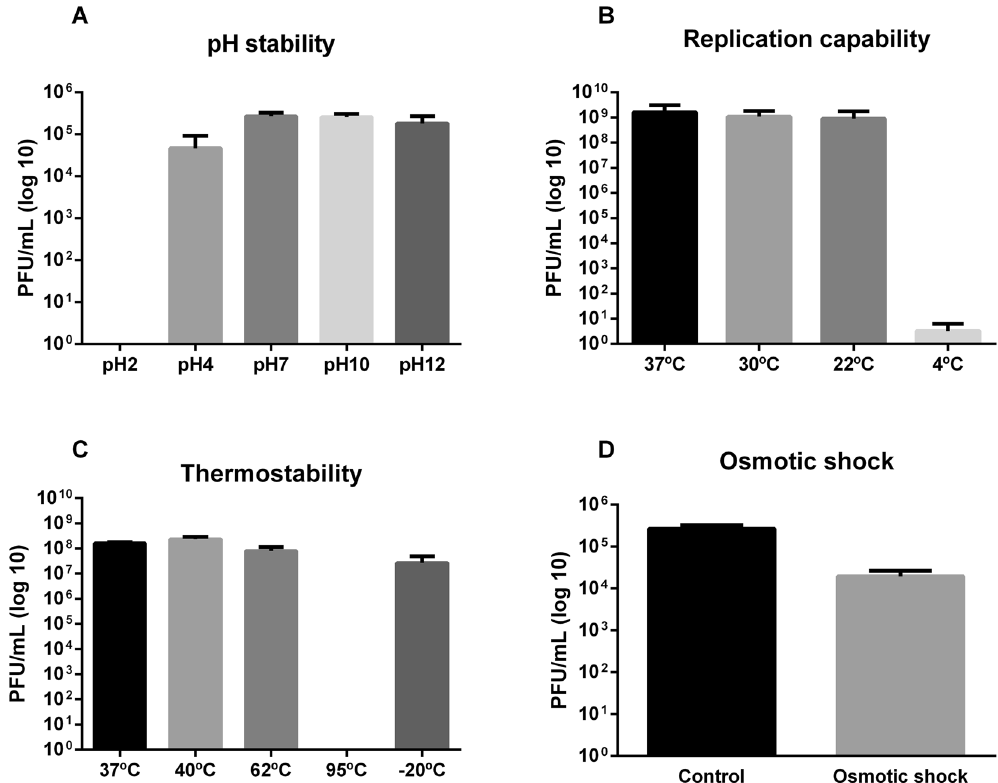
Figure 4. The stability of vB_EcoM-UFV13 under different conditions was evaluated. ( A ) Reductions of 100, 82, 4 and 32% of viable particles were observed after incubations, respectively, at pHs 2, 4, 10 and 12. ( B ) vB_ EcoM-UFV13 was able to replicate at 30 and 22 °C with an efficiency of plating of 69 and 56%, corresponding; ( C ) vB_EcoM-UFV13 was inactivated at 95 °C for 5 min; ( D ) Osmotic shock changing reduced in 84% viral